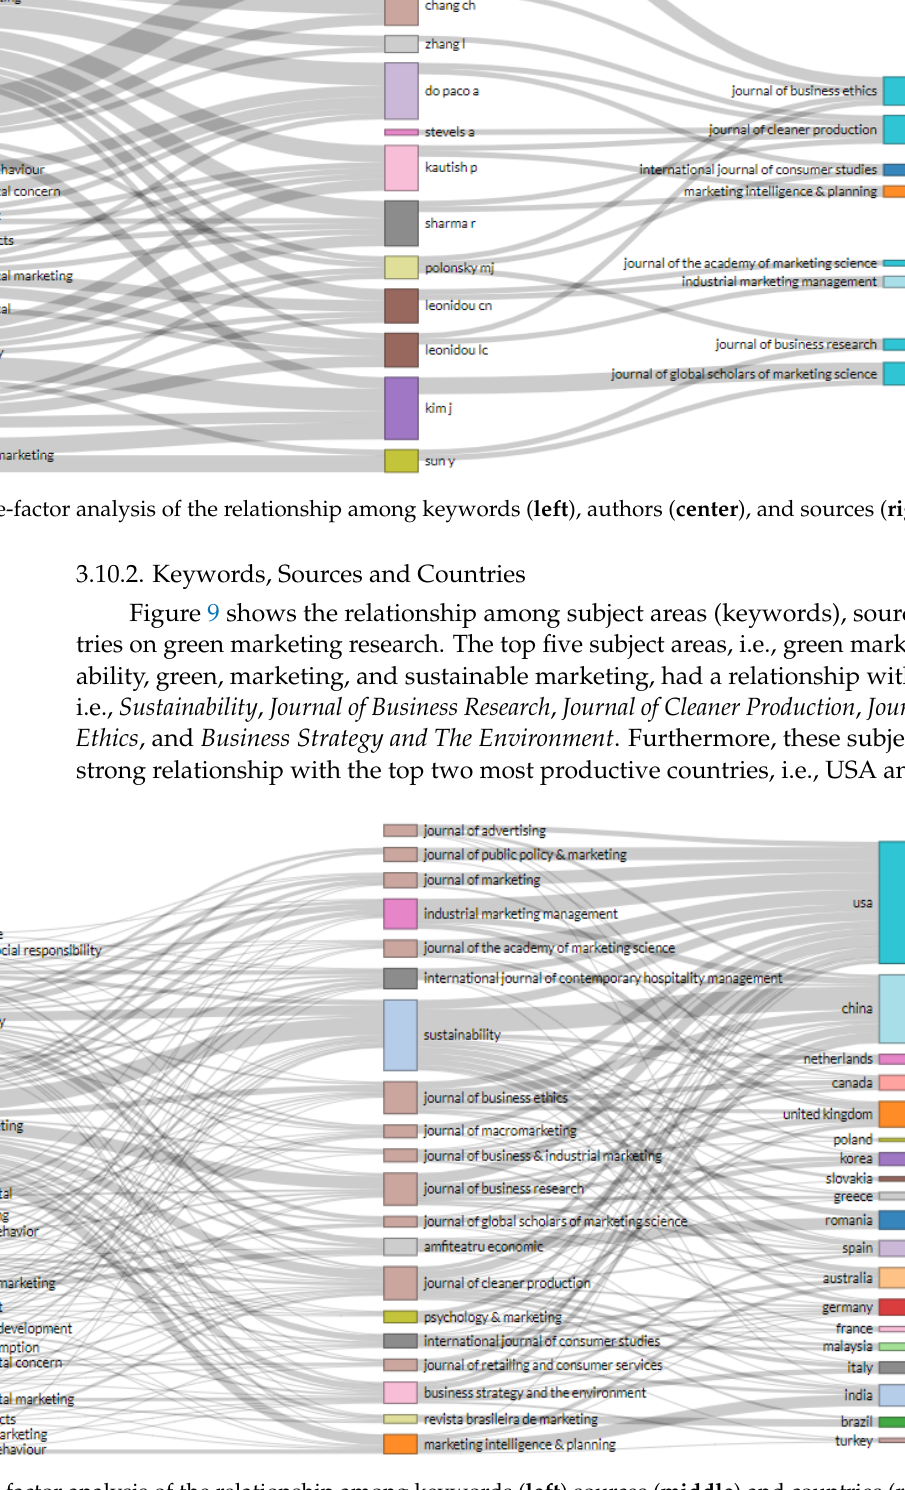
Figure 9. Three-factor analysis of the relationship among keywords ( left ) sources ( middle ) and countries ( right ).